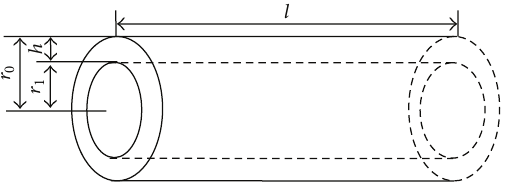
Figure 1: Schematic diagram of the dimension variation for clubbed X80